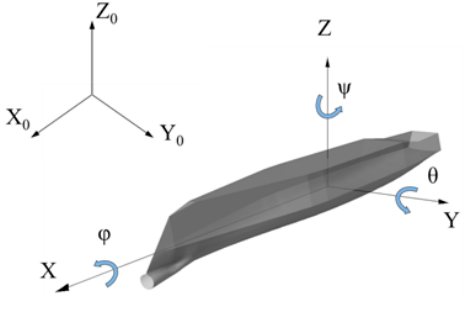
Figure 1. Coordinate systems.